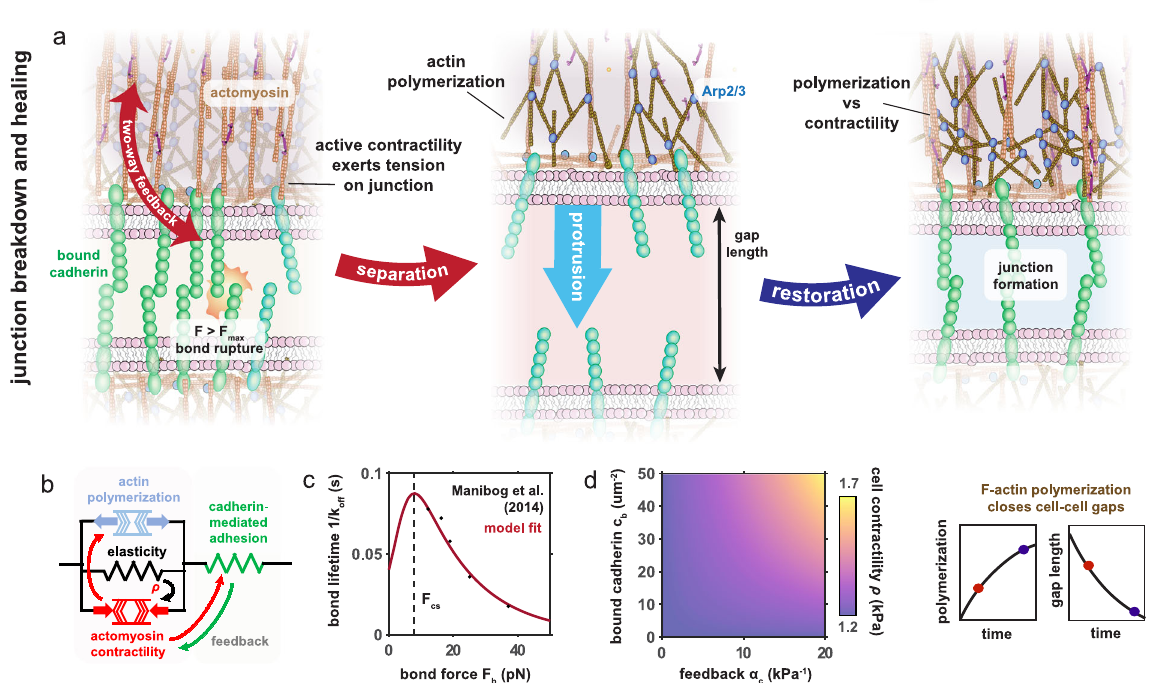
Fig. 2 | Feedback between mechanosensitive signaling and active forces gov- erns endothelial junction remodeling. a Schematic highlighting the proposed model: In connected cells active cell tension stabilizes cadherin bonds which in turn anchor the actomyosin network and mediate signaling. High tension drives bond failure and cell separation (red). Following adhesion rupture Arp2/3 medi- ated actin polymerization generates protrusive stresses which can ultimately lead to junction restoration (blue); ( b ) chemo-mechanical model considers stresses